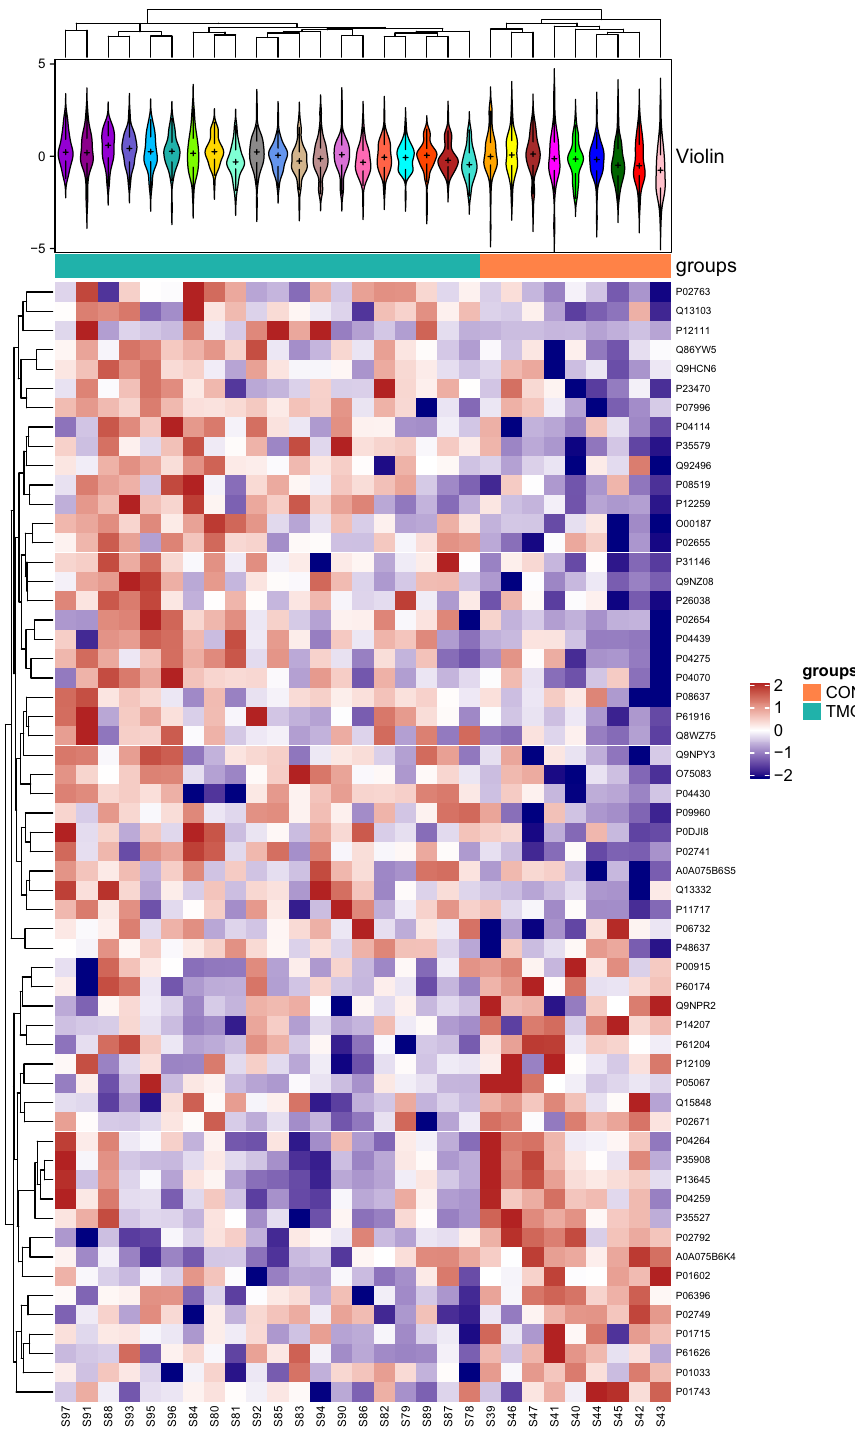
Figure 4. Clustering heat map of all proteins. At the top is a violin diagram, a combination of a box and density diagram, indicating the probability distribution of the expression value of the sample. A flatter violin indicates a more concentrated data. Different color fillings represent different samples. The median of the data is represented by the "+" symbol in the middle, and the vertical axis shows the protein expression level. Below the violin is a column annotated heat map, where samples of the same group are represented by blocks of the same color. The clustering heat map below organizes proteins based on expression levels, with red indicating high expression and blue representing low expression, each row representing protein expression across different groups. The software used to create the map is R 4.1.0 (https:// www.r- proje ct.